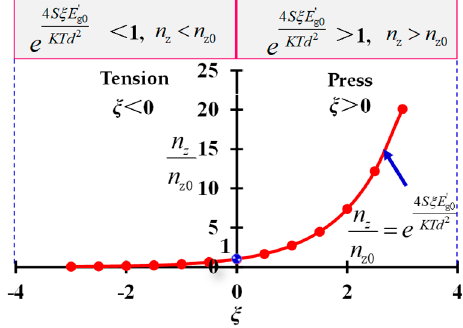
Figure 7. Variation of the concentration of carriers.